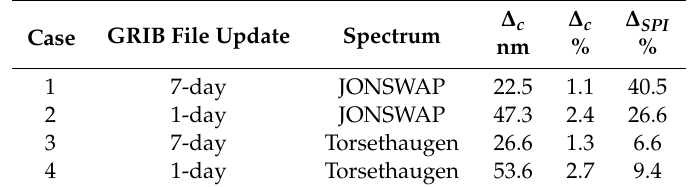
Table 3. Results of optimal route detection, F N = 0.15.